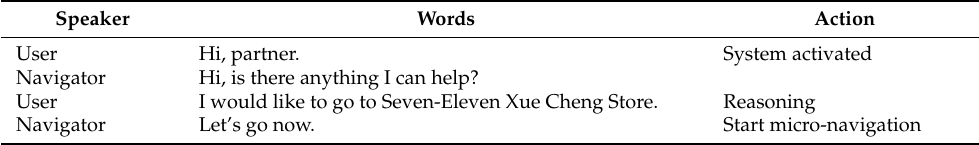
Table 1. Display of the dialogue process of the navigation system in the first scenario.